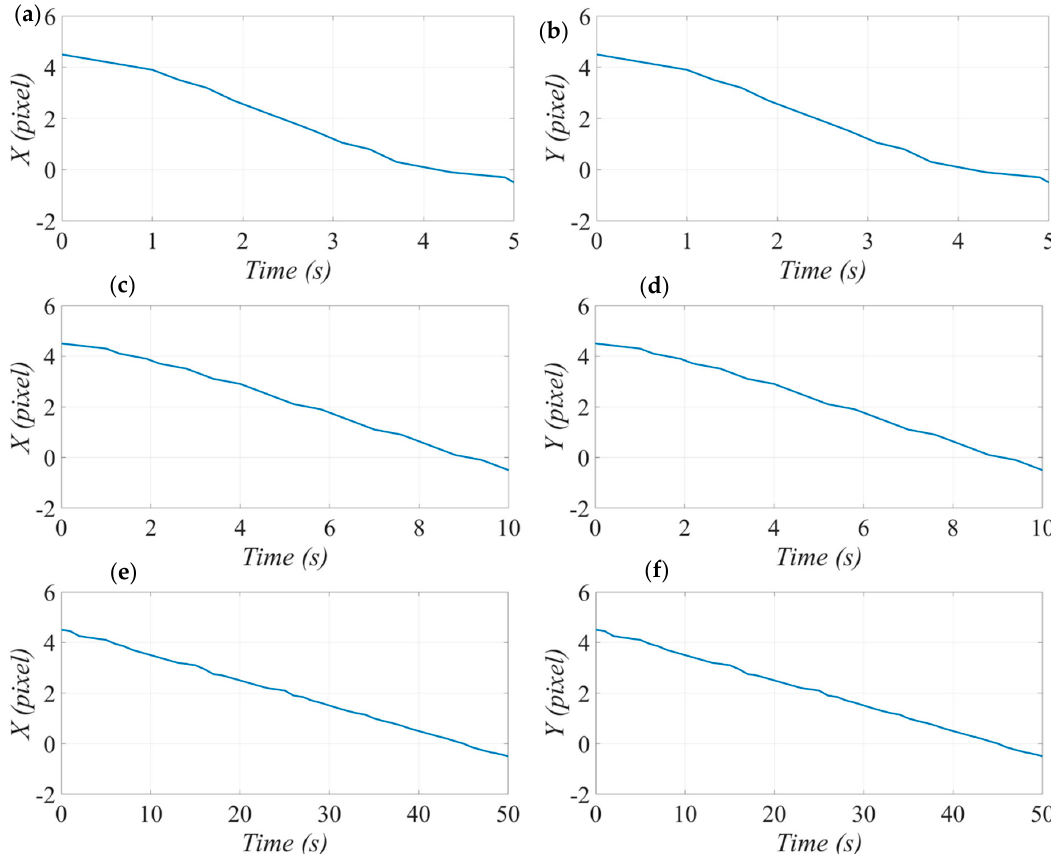
Figure 31. Position–time diagrams of X–Y plane: ( a ) x -axis and ( b ) y -axis in Case 1; ( c ) x -axis and ( d ) y -axis in Case 2; and ( e ) x -axis and ( f ) y -axis in Case 3.